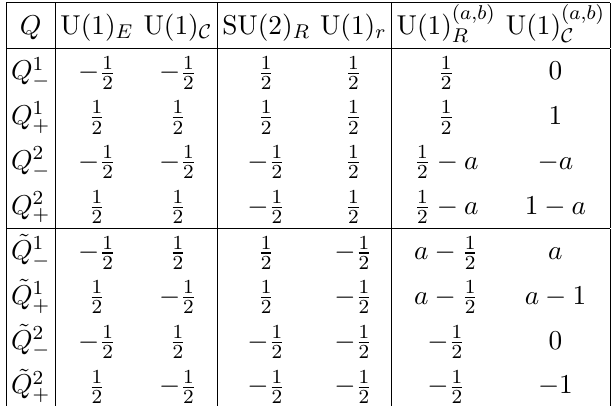
Table 2. Supercharges of the d = 4 ; N = 2 supersymmetry upon twisting. Here U(1) ( a;b ) with a + b = 1, and U(1) E is the 2d Lorentz group, and U(1) C is the Lorentz group on C